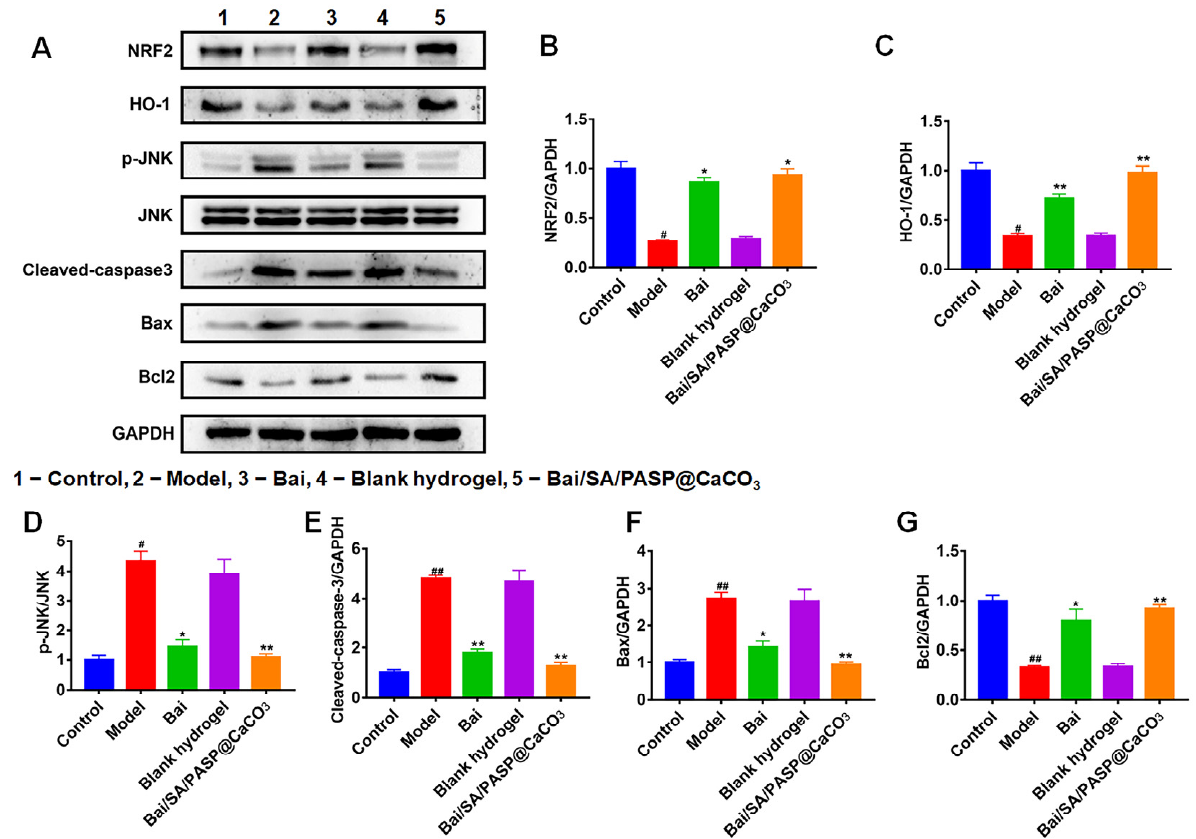
Figure 4. ( A ) The expressions of NRF2/HO-1 signaling related proteins on GES-1 cells after treated with Bai/SA/PASP@CaCO 3 hydrogel. Quantitative analysis of NRF2 ( B ), HO-1 ( C ), p-JNK ( D ), Cleaved-caspase-3 ( E ), Bax ( F ), and Bcl2 ( G ) by Image J, according to Section A. Significant differ- ence from the control group: # p < 0.05, ## p < 0.01. Significant differences from the model group: * p < 0.05, ** p < 0.01.